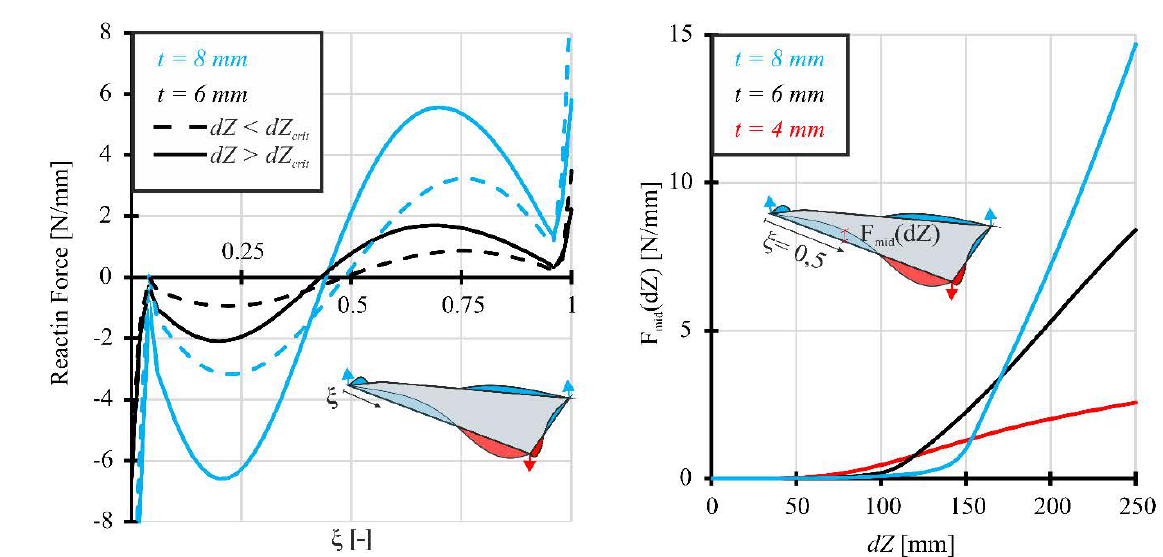
Fig. 7 (left) Support reactions over the edge’s length for buckled and unbuckled plates, (right) Reaction force F mid (dZ) in the middle of the edge depending on the corner displacement